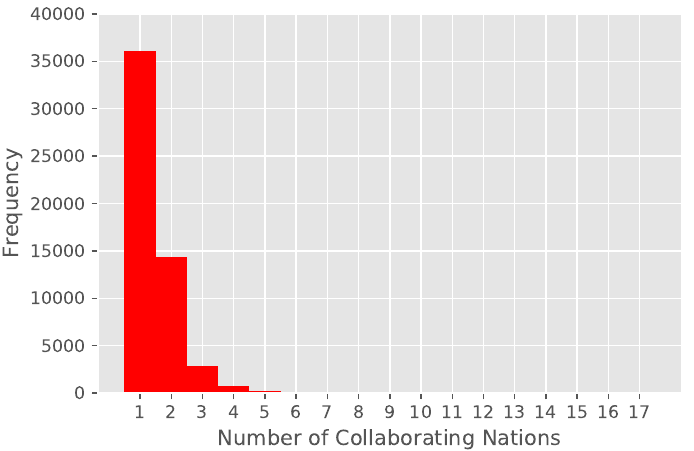
Figure 6. A histogram of the number of different nations represented on papers published in MDPI journals between 1996 and 2018 which include at least one author from a nation in the lower-middle-income classification.